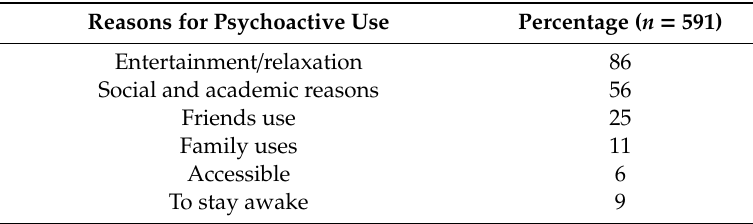
Table 2. Reasons for current psychoactive substance use among Mekelle University undergraduate students in Ethiopia in 2017.